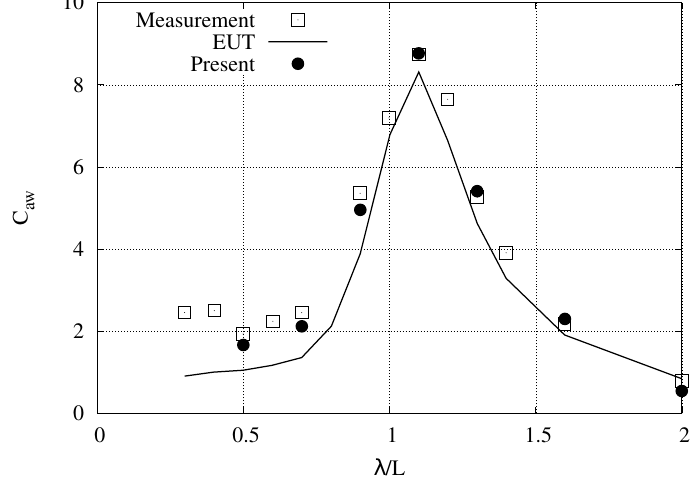
Figure 7. Added resistance of model 1 versus λ / L .